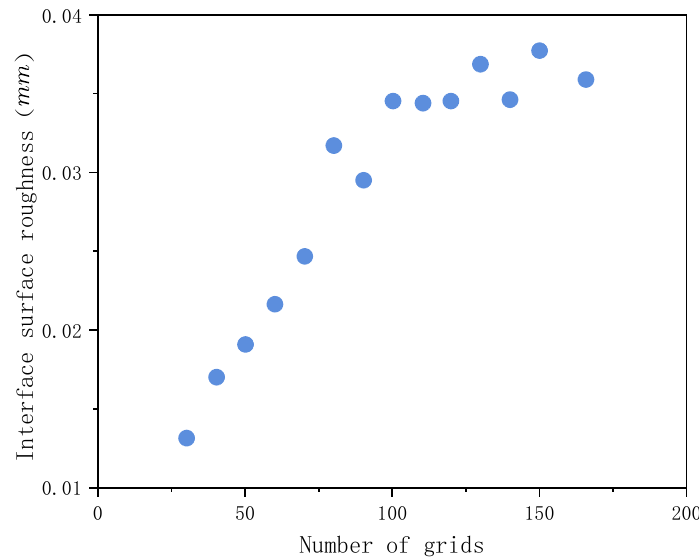
Figure 4. Effect of grid number on surface roughness.